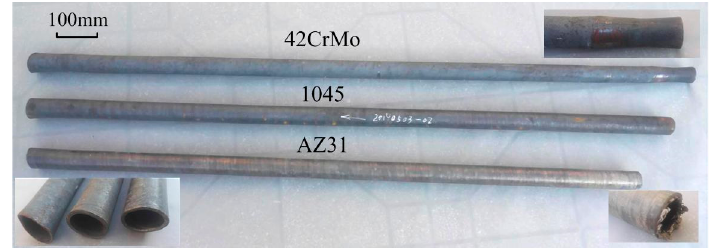
Figure 26. Finished seamless steel pipe prepared by tandem skew rolling [36] (Reprinted from ref. [36]).